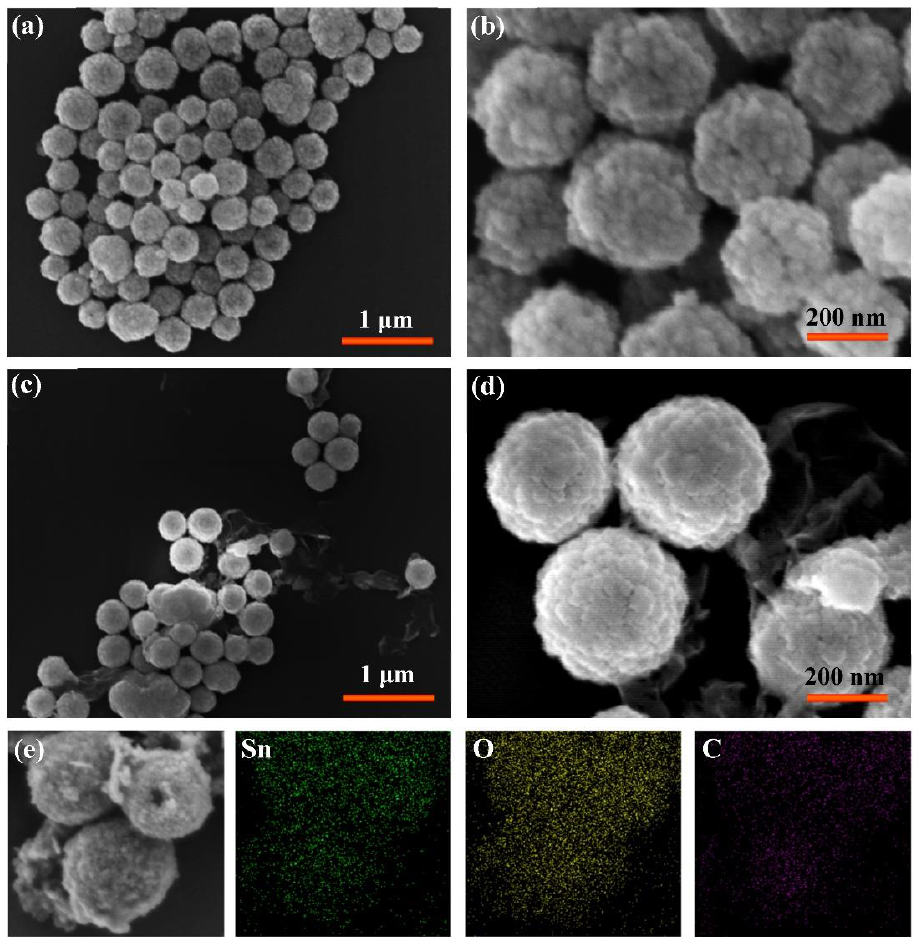
Figure 2. SEM images of two samples ( a , b ) SnO 2 and ( c , d ) r-SnO 2 /GN; ( e ) EDS mapping including Sn, O, and C elements for r-SnO 2 /GN.